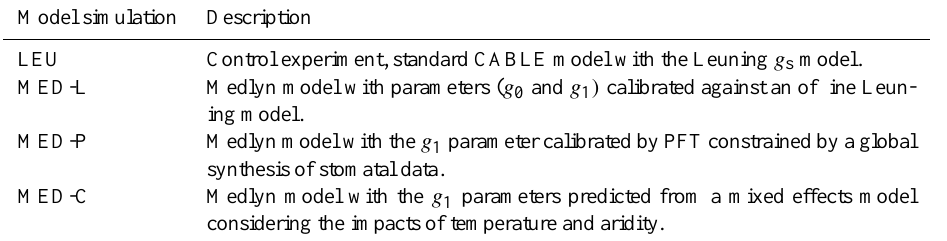
Table 3. A summary of model simulations.